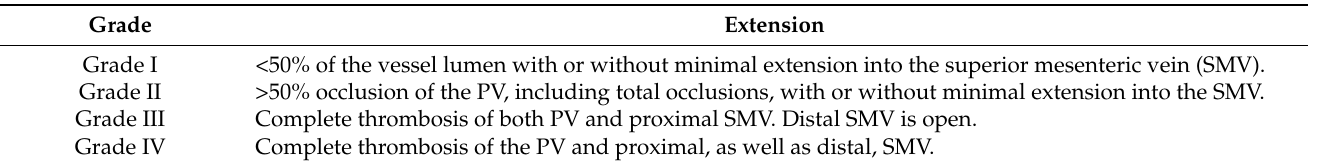
Table 2. Yerdel classification of portal vein